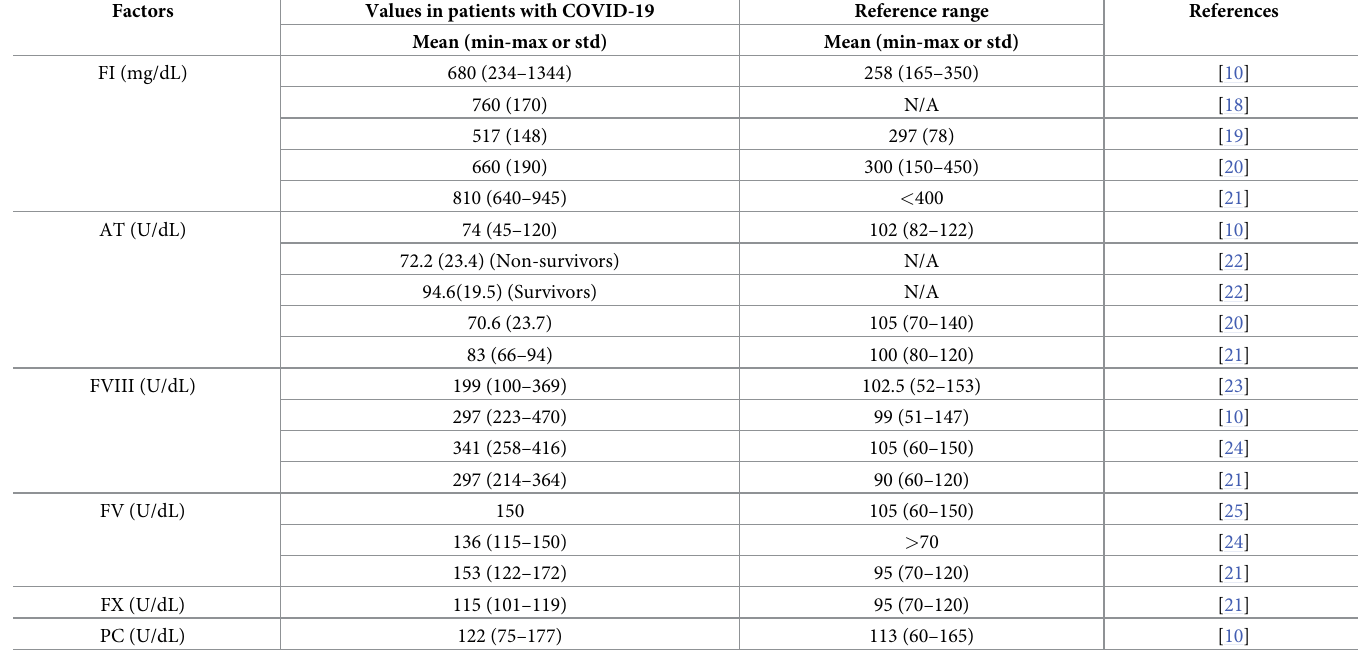
Table 1. Aberrant levels of coagulation factors in COVID-19. Factors Values in patients with